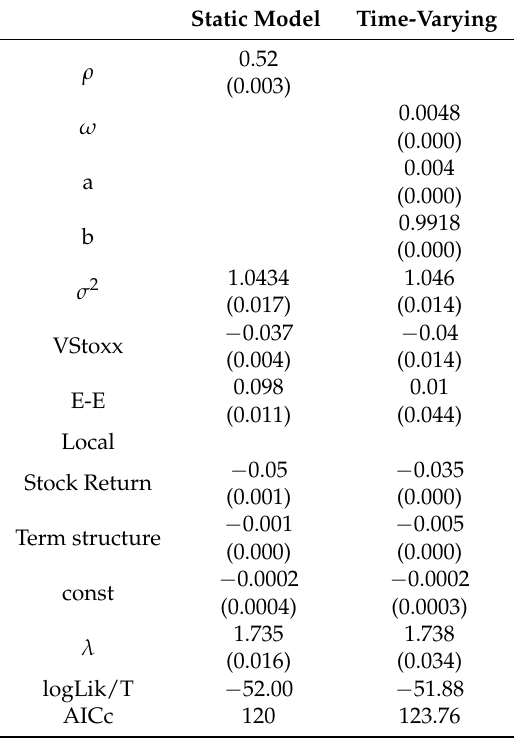
Table 1. The spatial model results. Estimated parameters and their robust (sandwich) standard errors in parentheses, for the static spatial lag model and the time-varying spatial model, based on Student’s t distributed